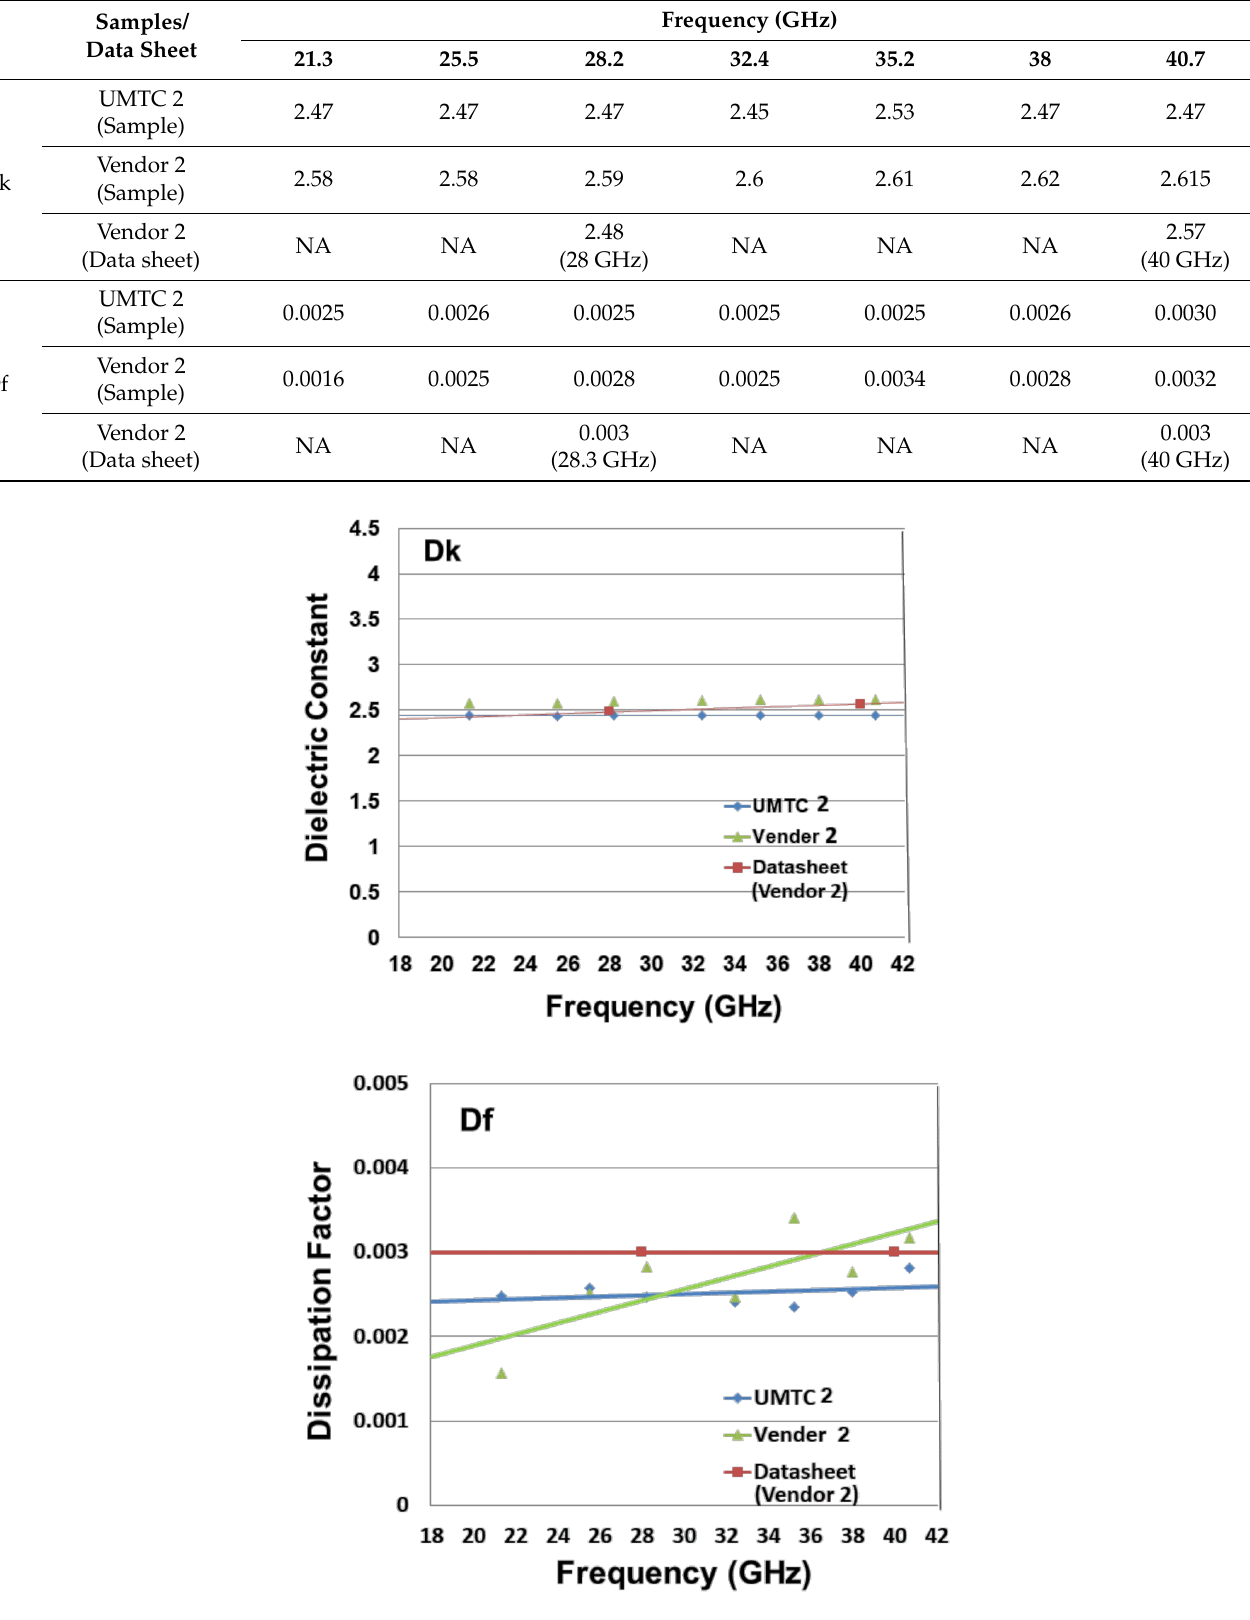
Figure 7. Dk and Df of Vendor